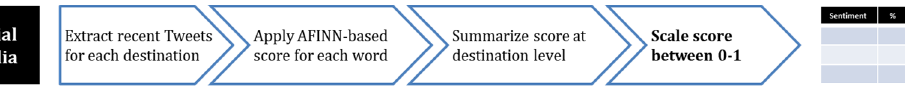
Figure 17. Big data analytics of social media information for thematic TRS.